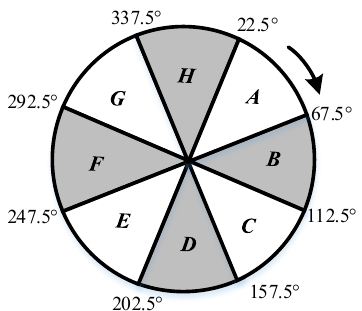
Figur e 6. Eight directions spider code of heading directions of trajectory points Figure 6. Eight directions spider code of heading directions of trajectory points.